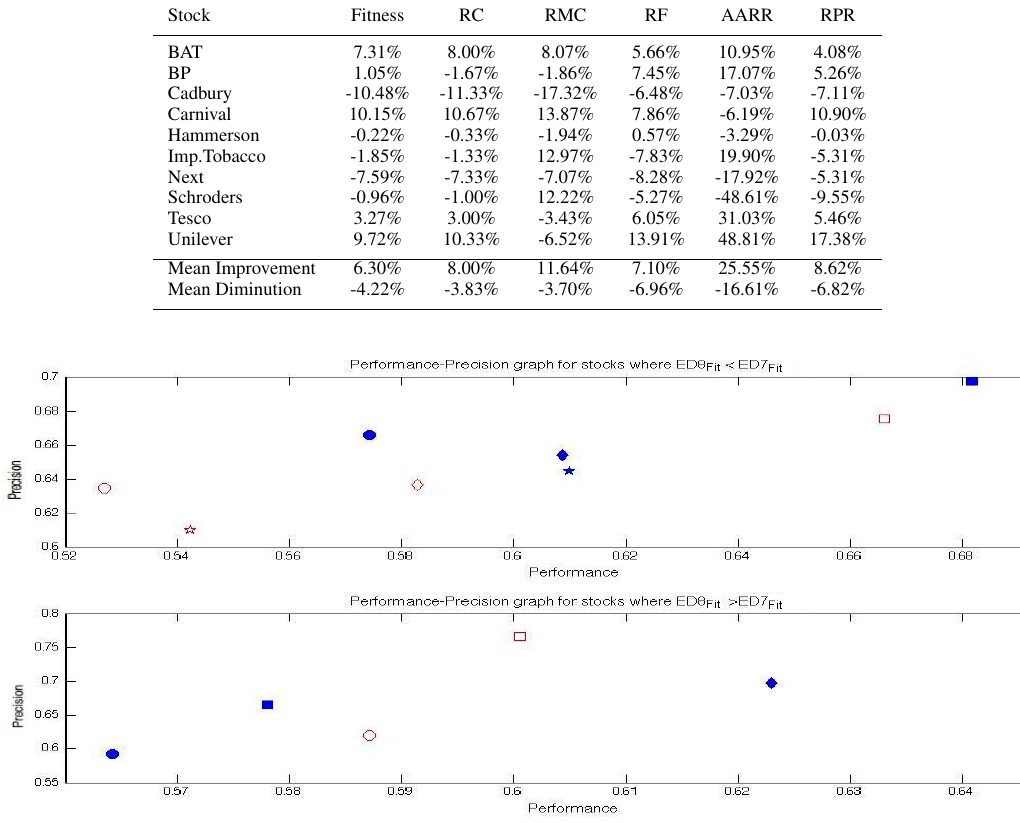
Table 5 Improvements and diminutions of Best-8 in Fitness and the other metrics, for all 10 stocks. The data presented in the first ten rows is basically the difference between metric values of EDDIE 8 and EDDIE 7. Finally, the last two rows of the table present the mean of the improvements and diminutions of the Best-8 to the metrics.